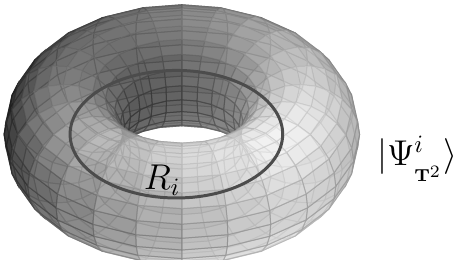
Figure 4 . The state j (cid:9) i i 2 H can be produced by performing the Chern-Simons theory path T 2 T 2 integral in a solid torus with a Wilson line in the representation R i placed along the non-contractible cycle of the solid